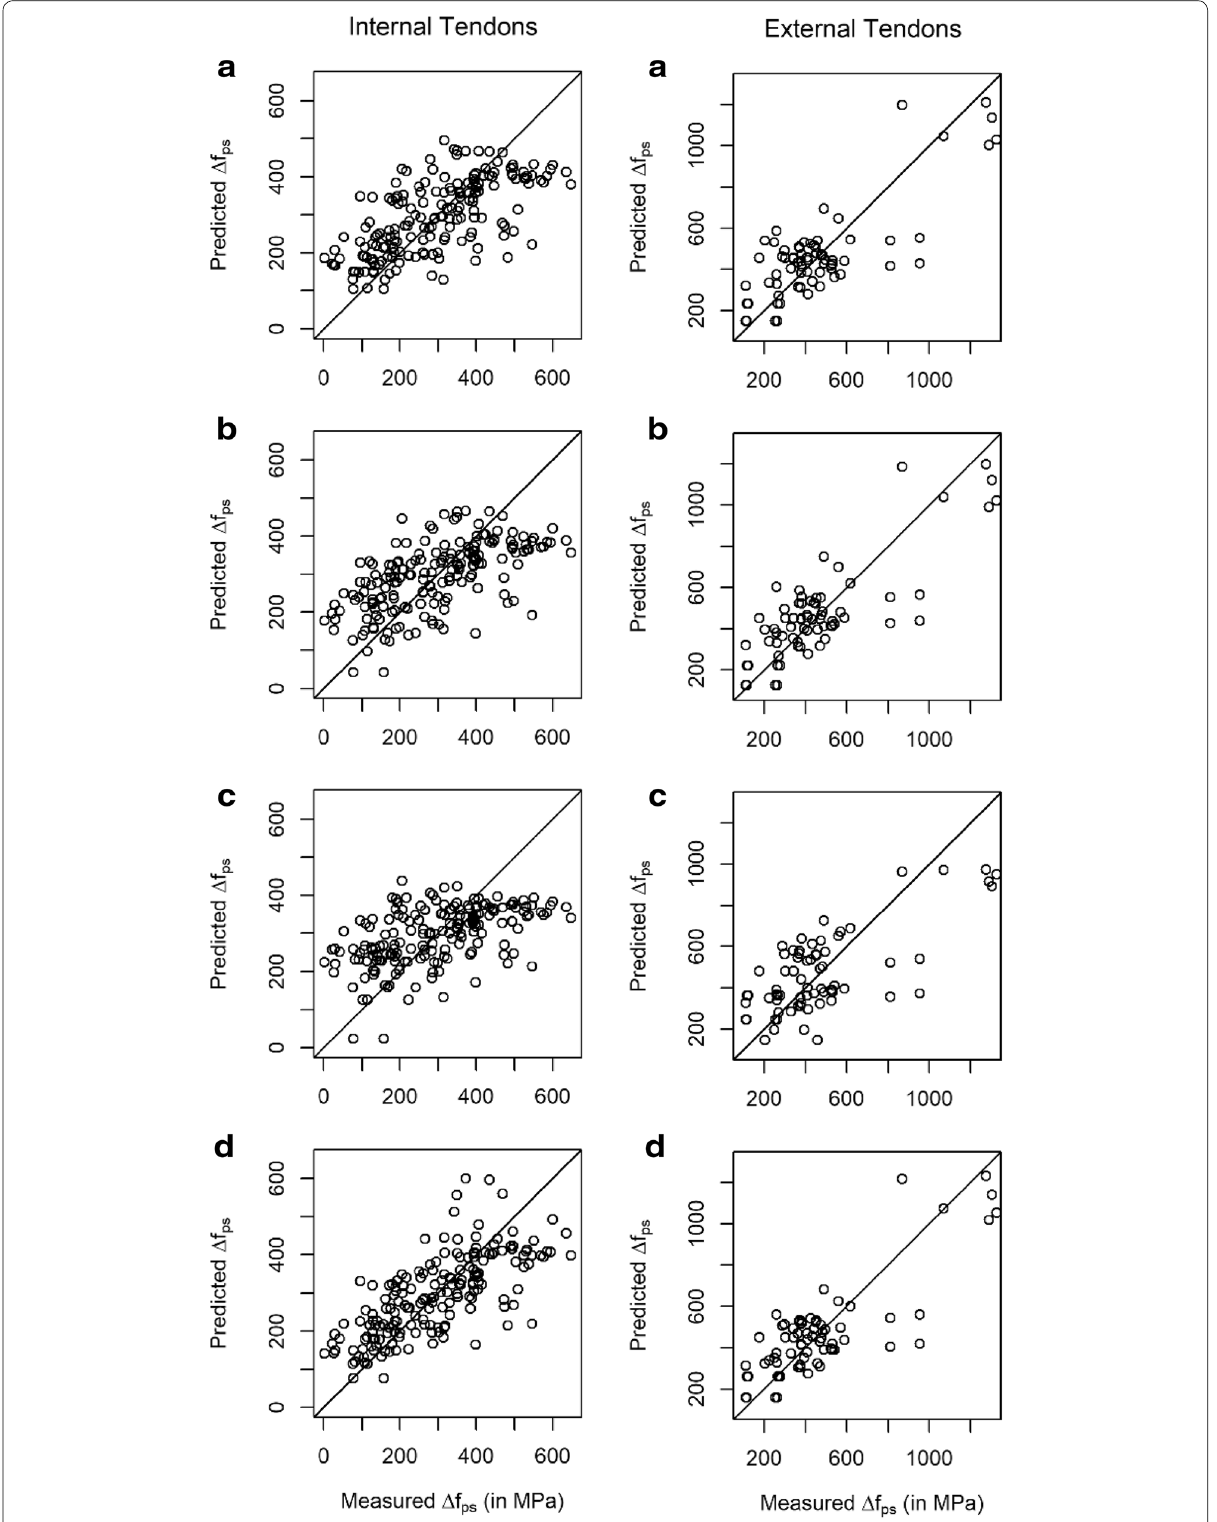
Fig. 2 Measured (cid:31) f ps vs. predicted (cid:31) f ps (in MPa) from the PCA models using a all variables, and the b combined Continuous and Categorical, c Self-Selected, and d Correlation Cutoff variable